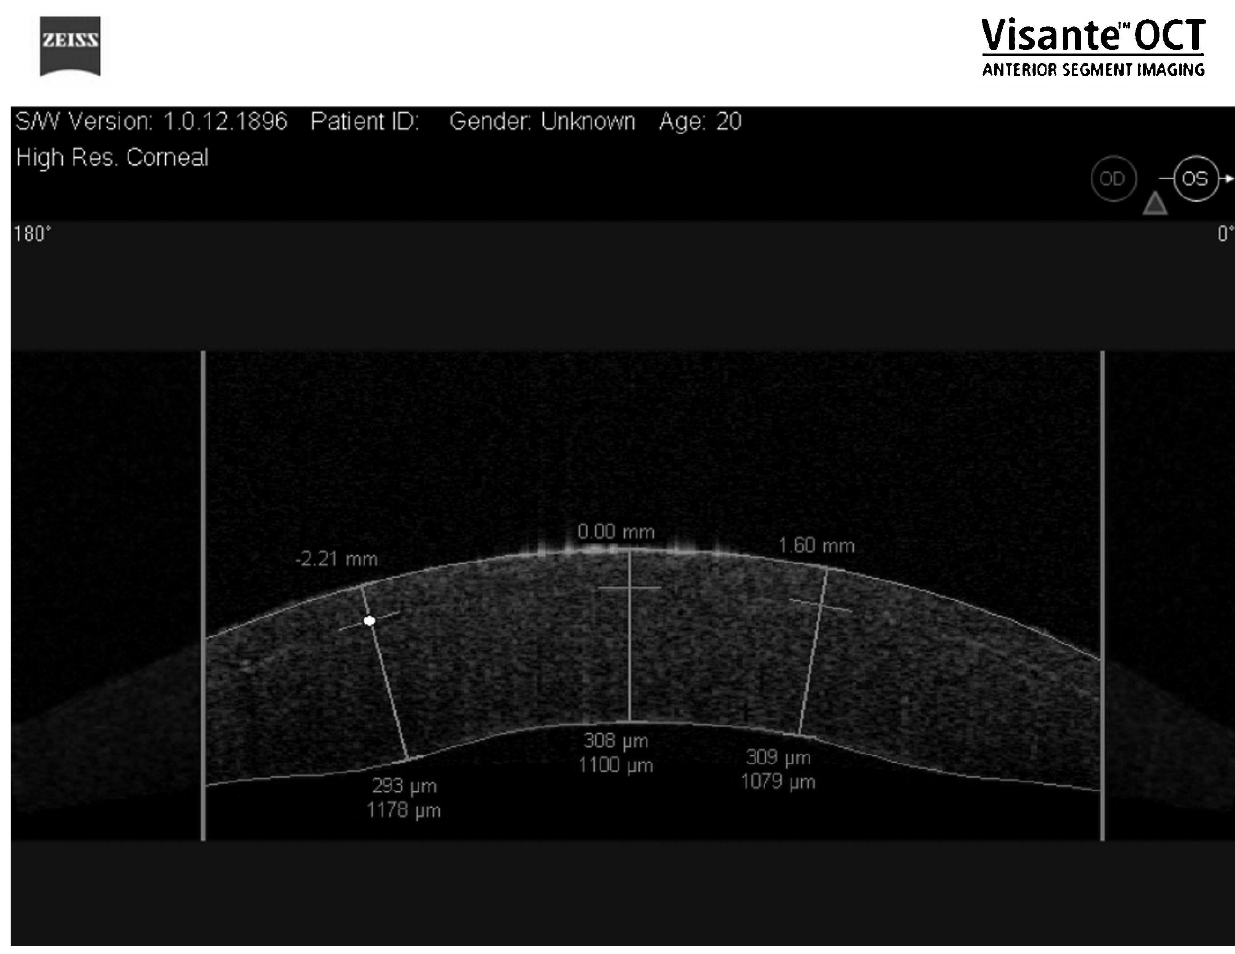
Figure 2 - OCT image of a thick flap created with the